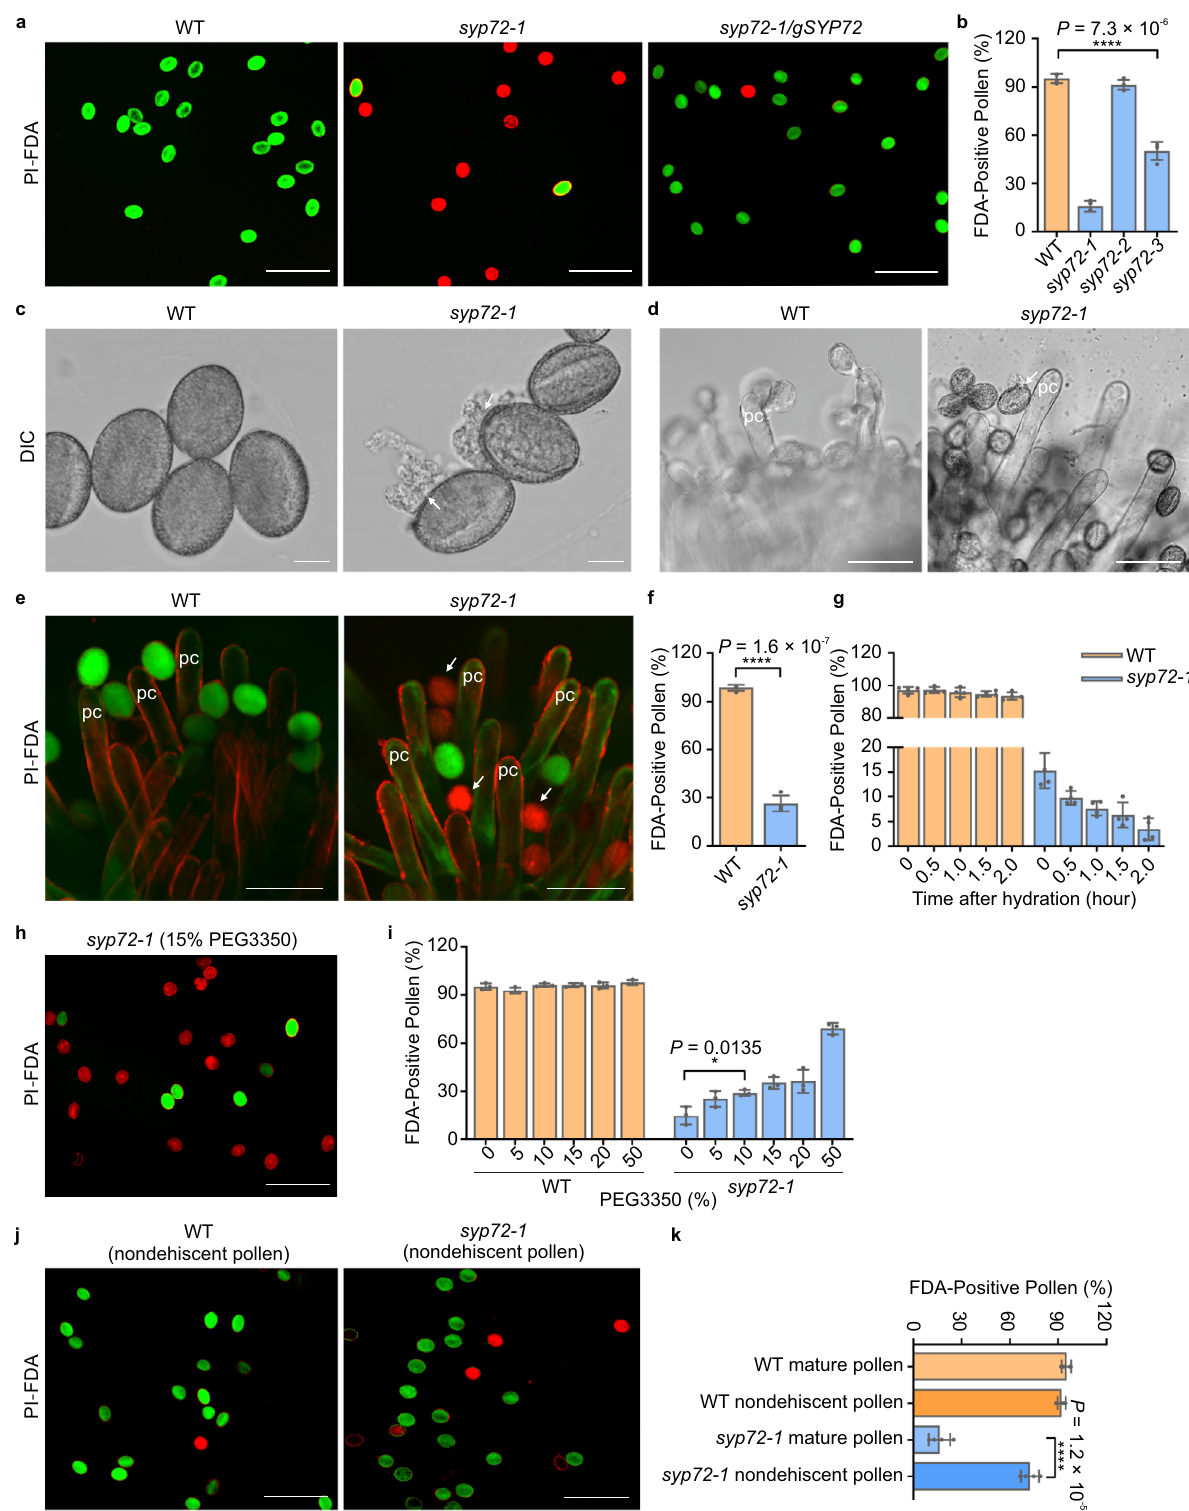
(Fig. 4f – h). As the localization of membrane ion channels to the plasma membrane is critical for their channel function, we then compared the intracellular location of MSL8 in syp72-1 and WT. The intracellular location of MSL8 in syp72 pollen was distinct from that in WT pollen: MSL8 localized to the plasma membrane in WT pollen, but not in the syp72 mutant, where it instead exhibited a uniform intracellular distribution (Fig. 4i – k).